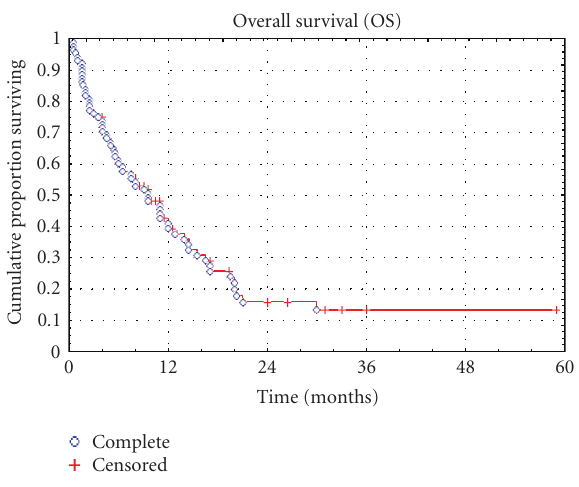
Figure 2: Kaplan-Meier curve of overall survival for the entire pop- ulation.